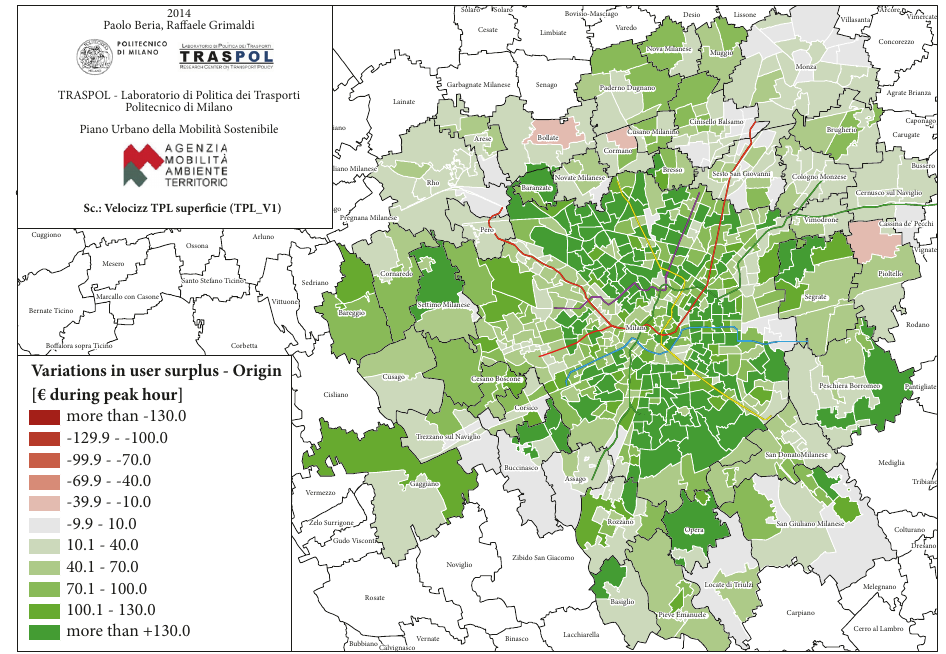
Figure 5: Variation in consumer surplus due to the generalised speeding up of the entire overground public transport (€ in the morning peak hour; our elaboration).